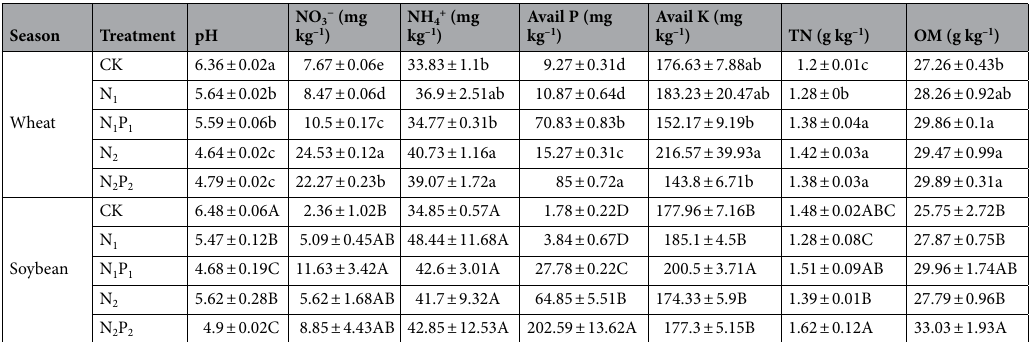
Table 1. Soil chemical properties of different fertilizer samples in wheat and soybean seasons. Values are mean ± standard deviation ( N = 3). Values within the same column followed by different letters indicate significant difference ( P < 0.05). Avail P indicates available phosphorus, Avail K is available potassium, TN is total N and OM is organic matter.